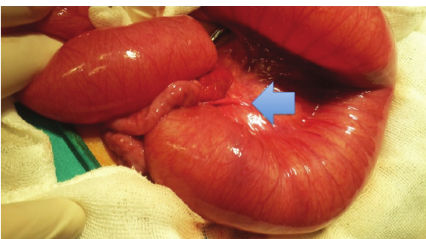
Figure 1: A congenital band between the ileum and mesentery of the terminal ileum.